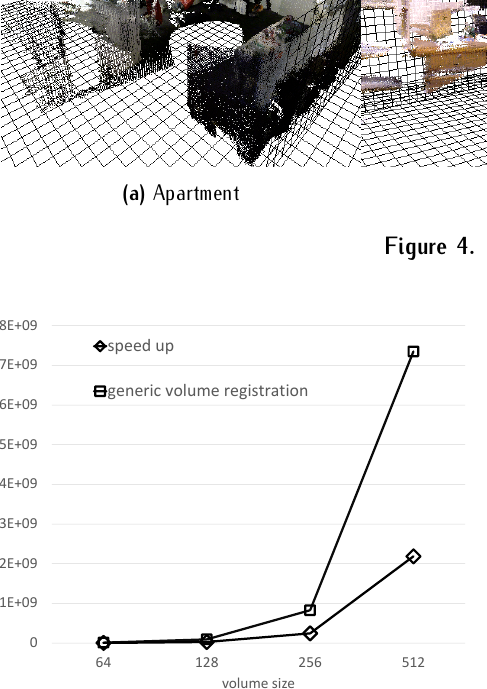
Figure 5. Comparison of performance between volume registra- tion and the proposed speed up for different volume